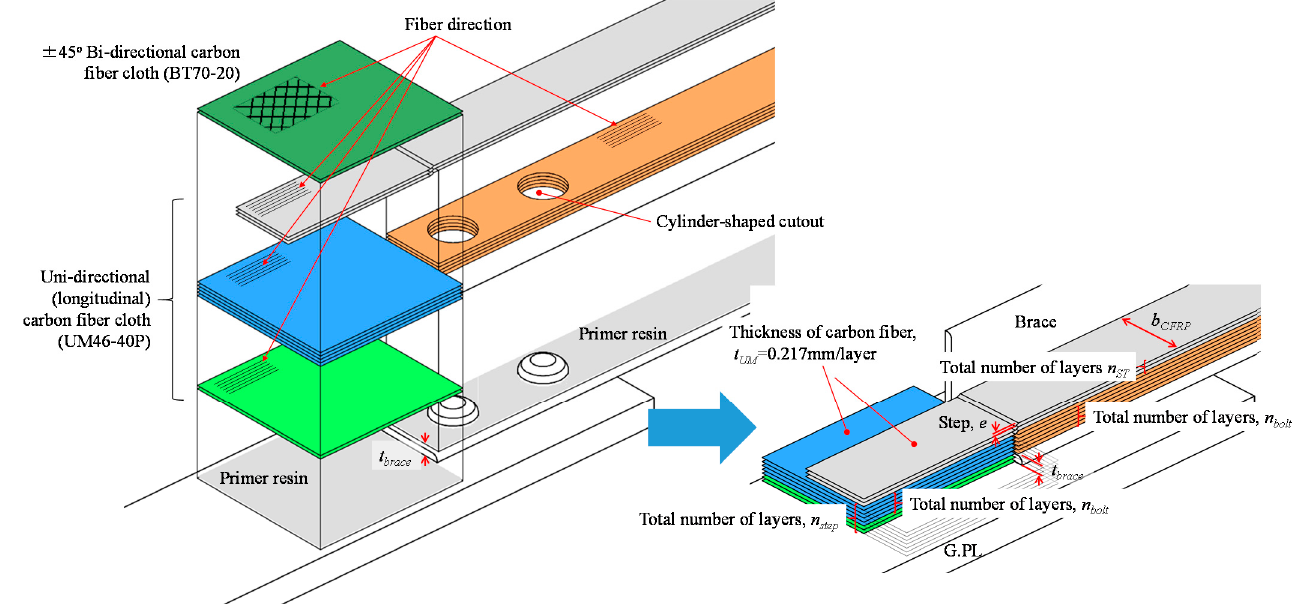
Figure 7. Strengthening method diagram and variables in Equations (7) and (8).